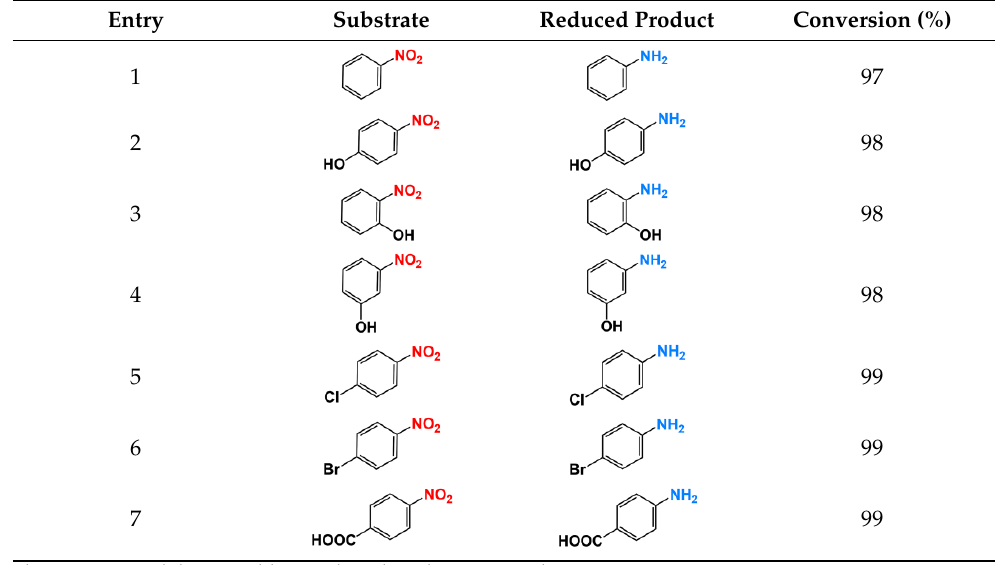
The experimental data in Table 1 are based on three repeated experiments.